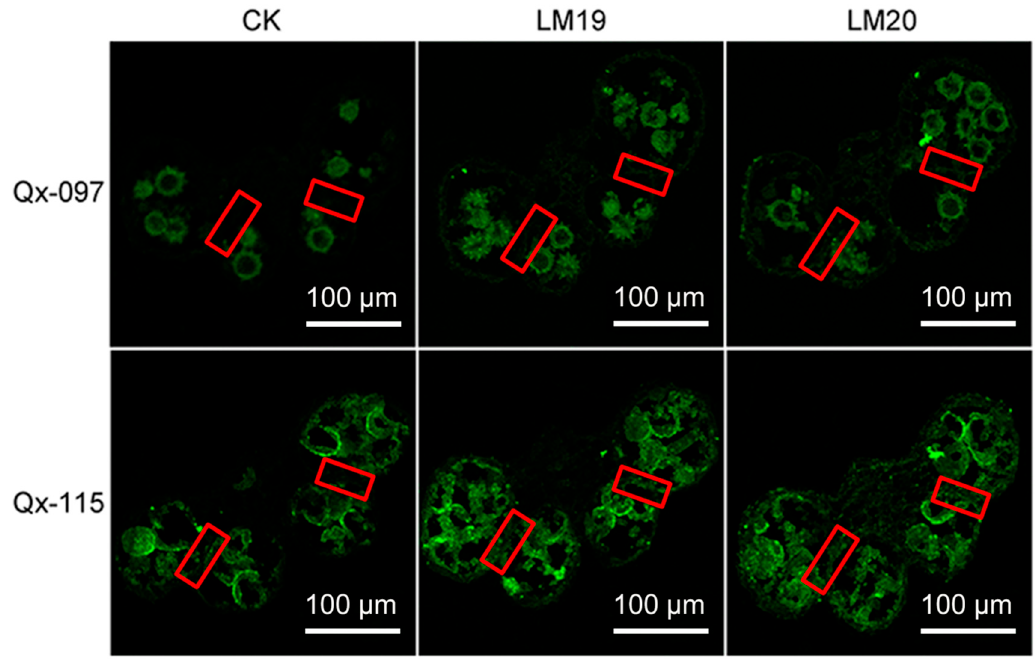
Figure 8. Immunofluorescence localization of LM19 and LM20 antibodies in the anthers (period 2) of chrysanthemum cultivars ‘Qx-097’ and ‘Qx-115’. Red squares mark the area of the stomium region in the anther. CK,